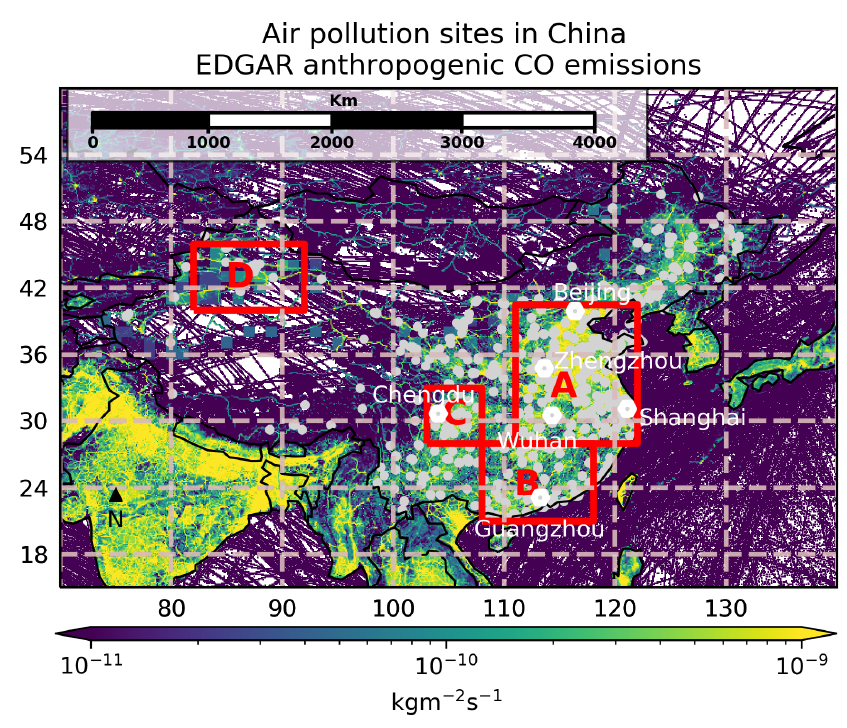
Figure 1. The location of the air pollution sites (light gray dots), six megacities (white hexagons) and regions (red boxes), together with the CO anthropogenic emission annual mean in 2015 from the Emissions Database for Global Atmospheric Research (EDGAR) v5.0